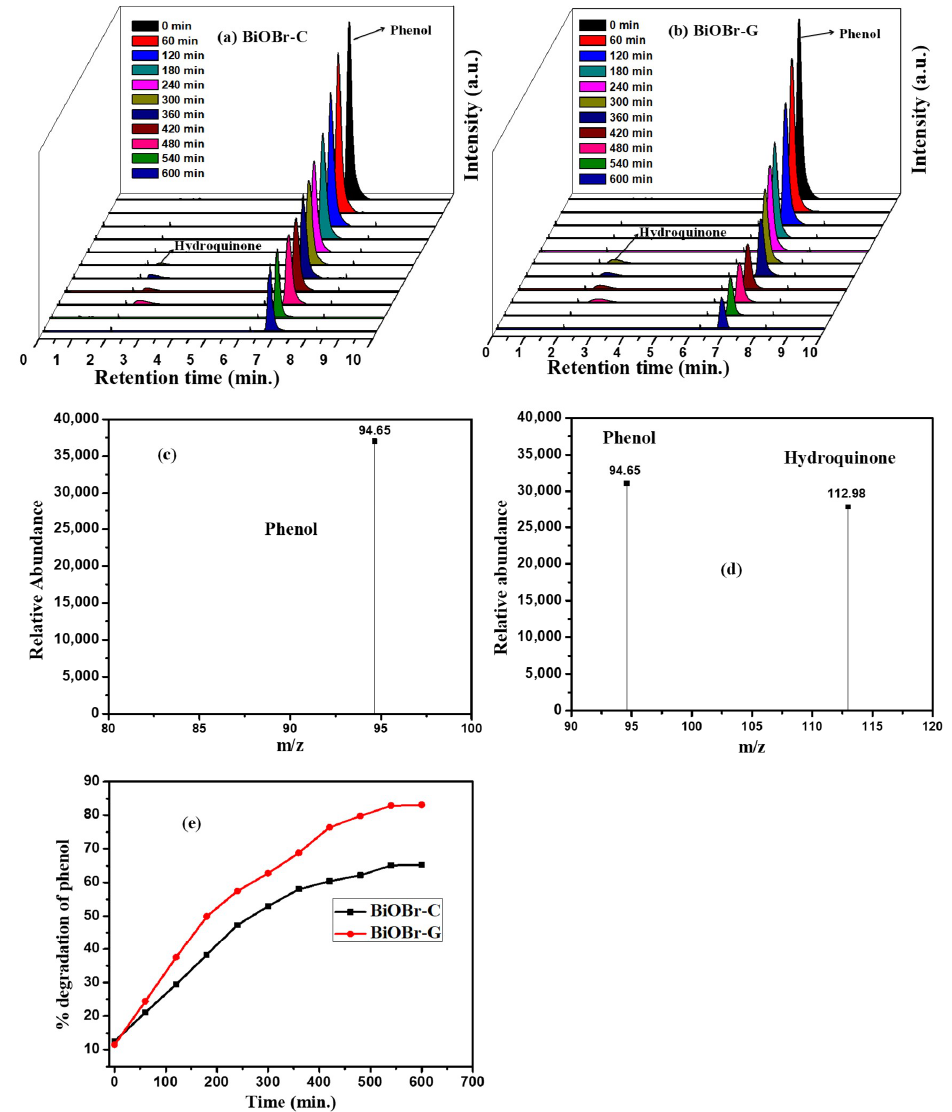
Figure 7. HPLC graphs of phenol degradation by ( a ) BiOBr-C, ( b ) BiOBr-G. Mass spectra of ( c ) phenol, ( d ) phenol and hydroquinone, and ( e )% degradation of phenol with time by HPLC data.